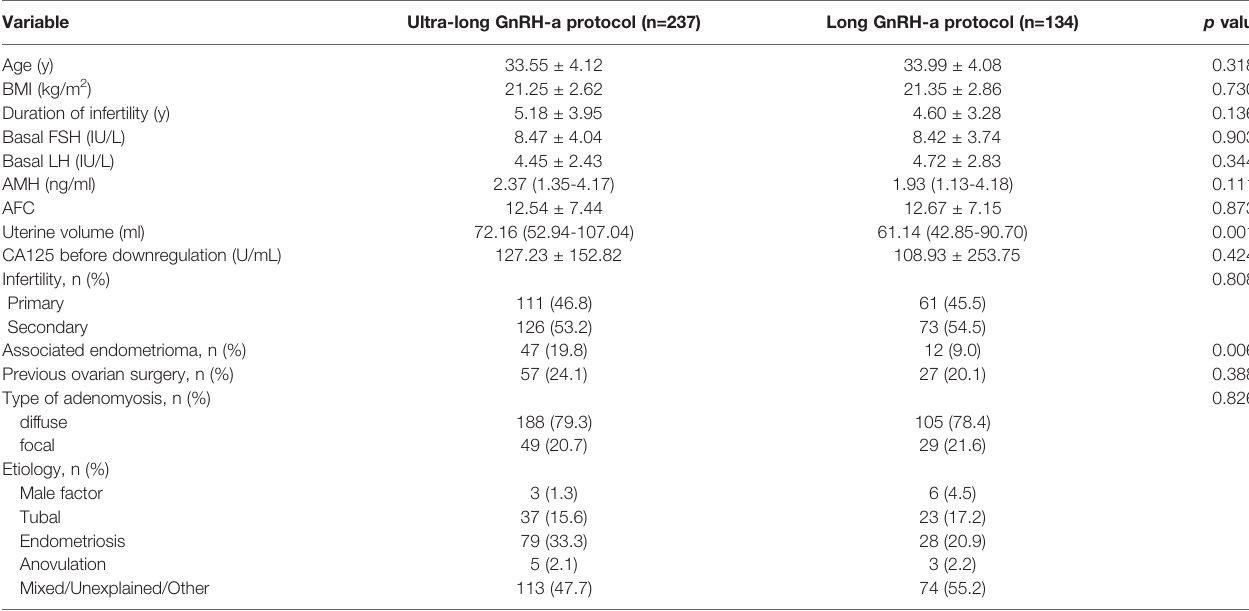
TABLE 1 | Baseline characteristics of the